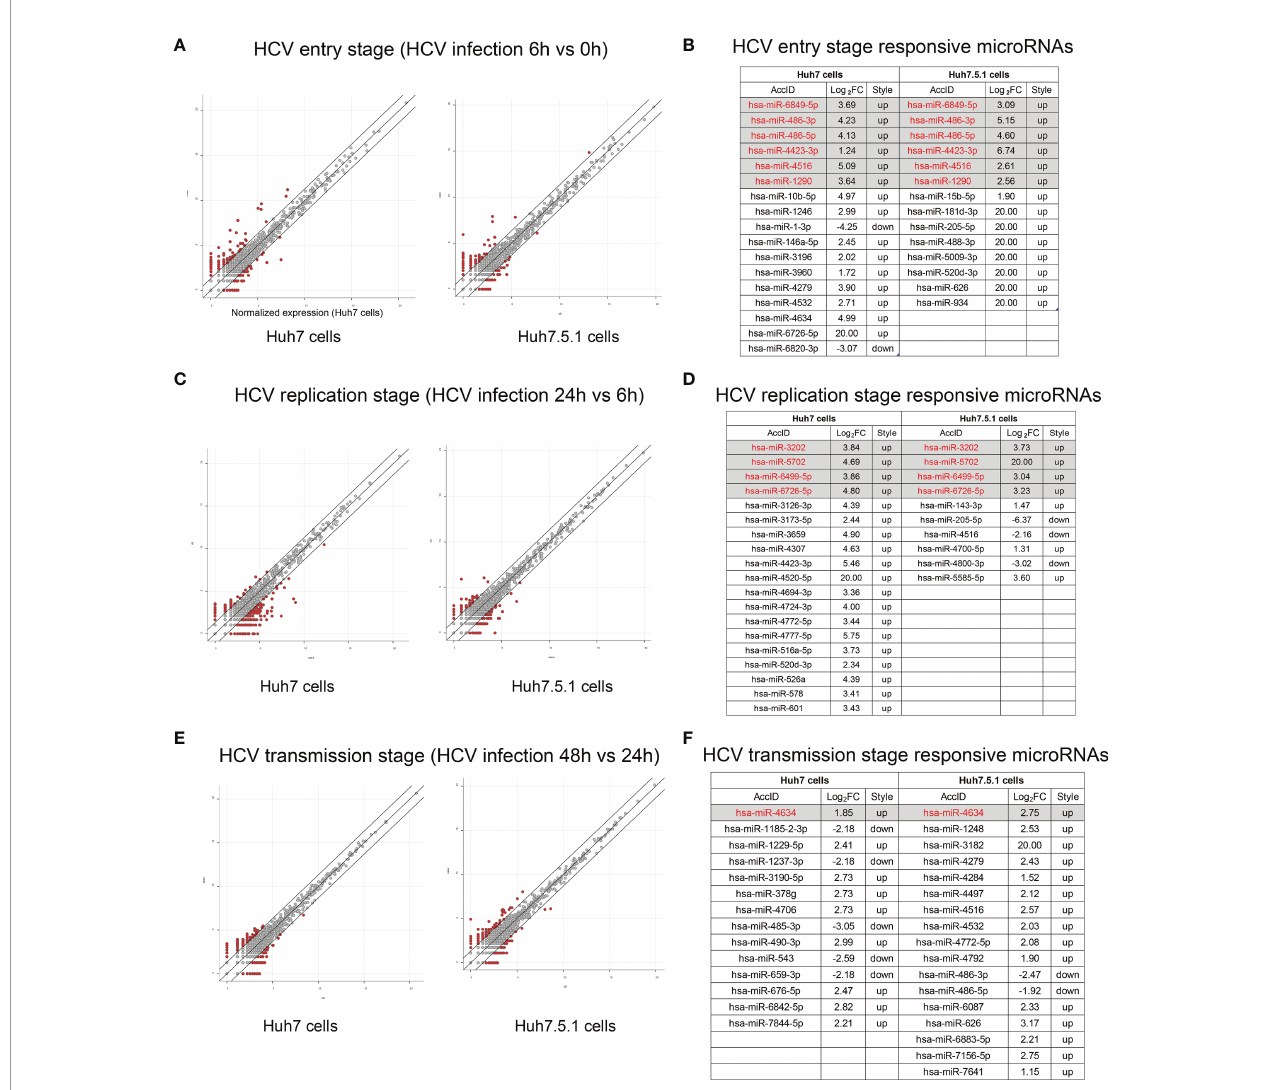
FIGURE 3 | Responsive miRNA expressions during different stages of HCV infection. (A) The scatter plot showed the differentially expressed miRNAs during entry stage, and miRNAs with more than 2 folds of expression fold change (FC) above were listed with the overlapped 6 miRNAs indicated under the gray background (B) . Similarly, scatter plot indicating HCV replication stage was shown (C) and relevant responsive miRNAs were listed as well (D) . MiRNAs altered during HCV transmission were scatter plotted (E) and illustrated (F)